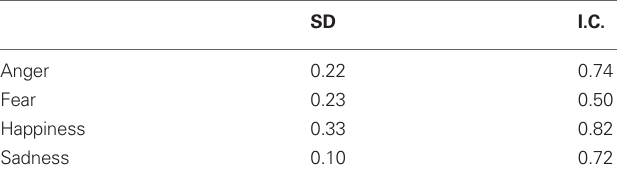
Table 2 | Cronbach’s alpha and mean SD of the accuracies of the emotion